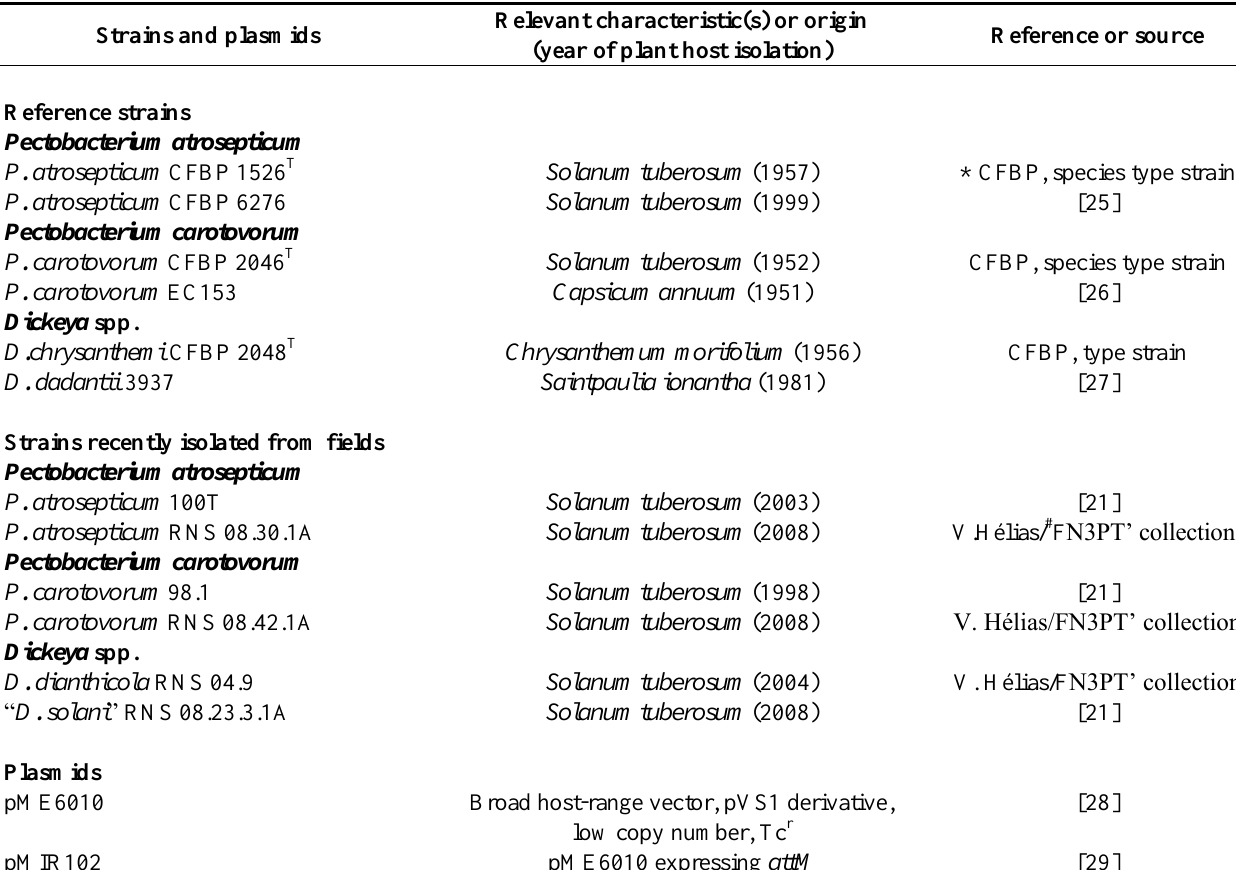
Table 1. Strains and plasmids used in the present